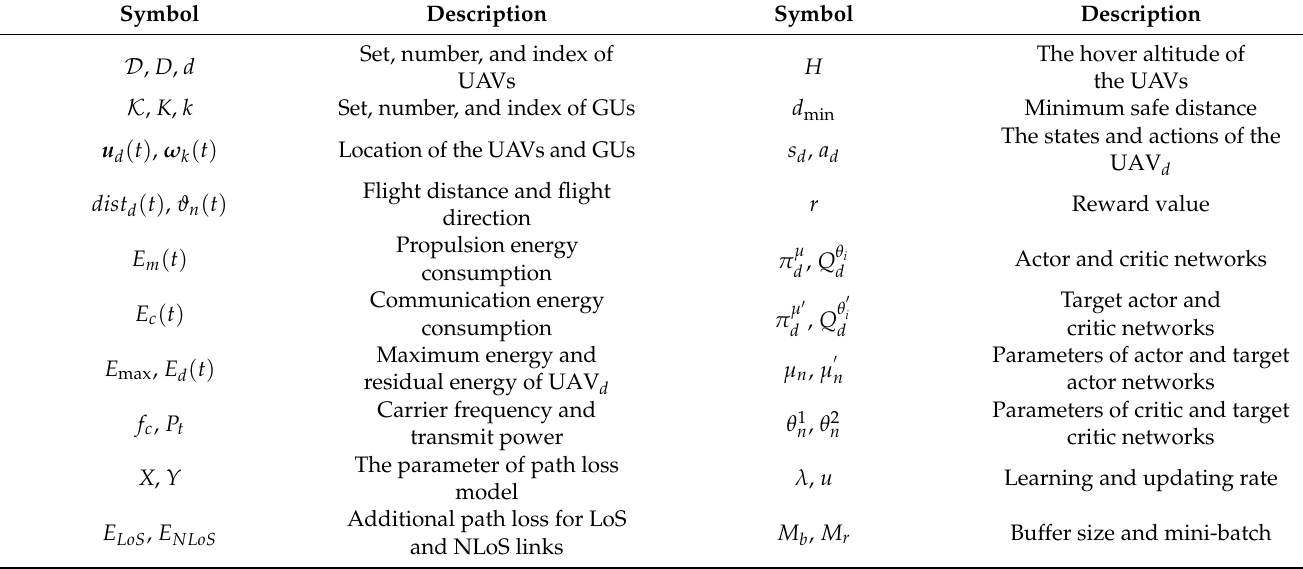
Table 1. Table of Important Symbols.